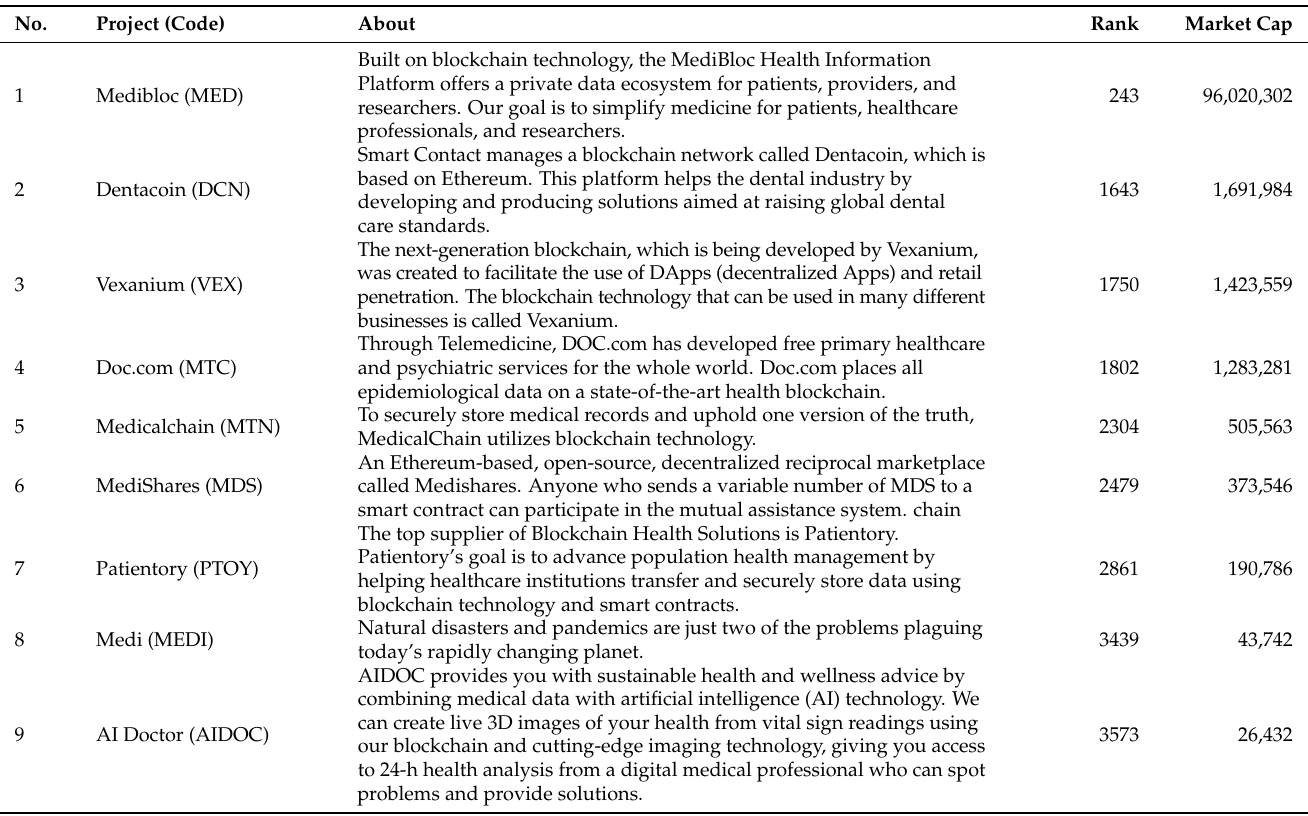
Table 5. Comparison of blockchain projects.